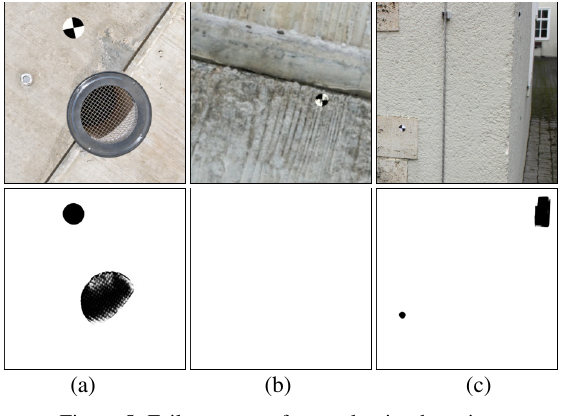
Figure 5. Failure cases of control point detection. Top row: input images, bottom row: